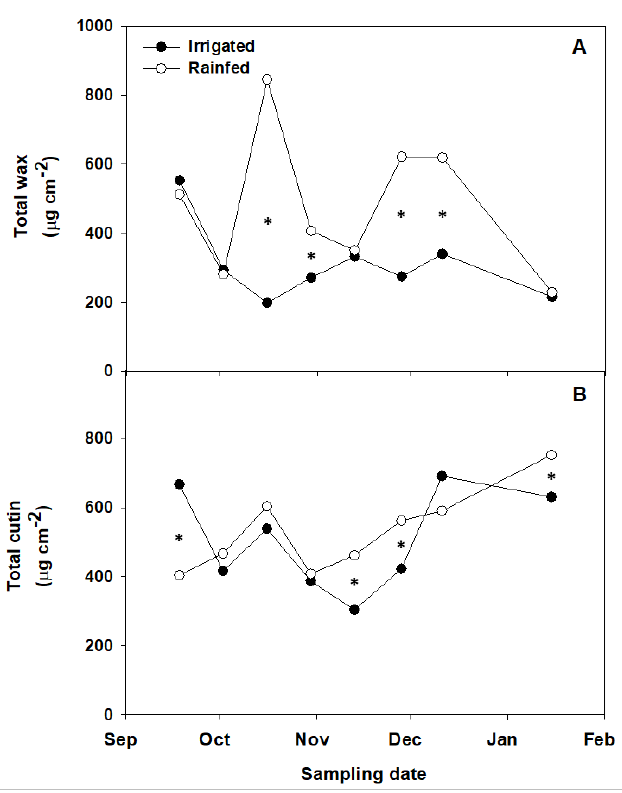
Figure 1. Total wax ( A ) and cutin ( B ) yields in fruit cuticles isolated during the ripening of irrigated and non-irrigated ‘Arbequina’ olives. Values represent means of three replicates. Asterisks stand for significant differences between irrigated and non-irrigated trees at p ≤ 0.05 (LSD te st).